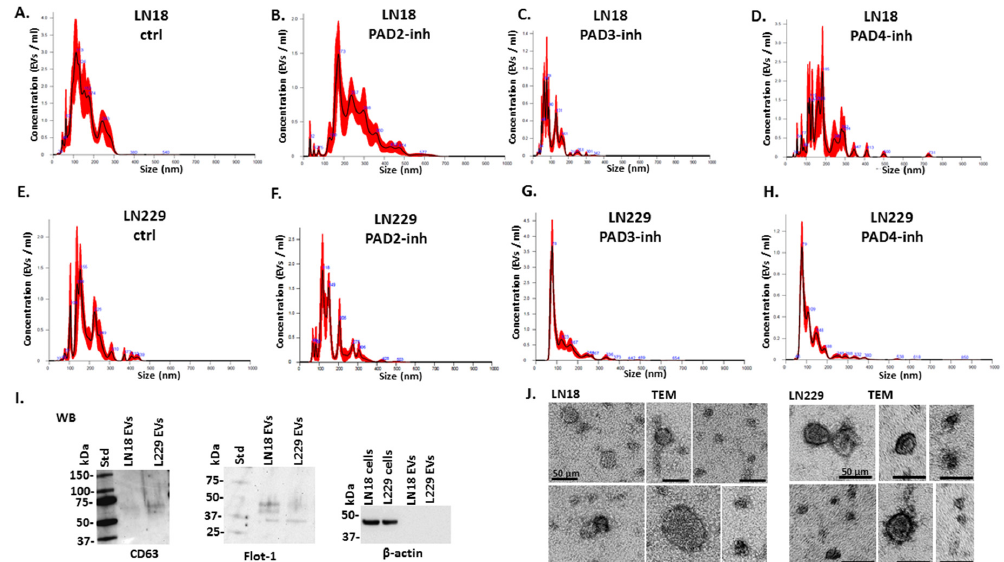
Figure 2. NTA size distribution profiles of EVs released from LN18 and LN229 cells following PAD isozyme-specific inhibitor treatment for 1 h and EV characterisation. Representative NTA profiles of LN18 cells following 1 h PAD inhibitor treatment ( A – D ): ( A ) Control DMSO treated cells; ( B ) PAD2 inhibitor treated cells; ( C ) PAD3 inhibitor treated cells; ( D ) PAD4 inhibitor treated cells. Representative NTA profiles of LN229 cells following 1 h PAD inhibitor treatment ( E – H ): ( E ) control DMSO treated cells; ( F ) PAD2 inhibitor treated cells; ( G ) PAD3 inhibitor treated cells; ( H ) PAD4 inhibitor treated cells. ( I ) Western blotting analysis (WB) showing that EVs isolated from LN18 and LN229 cells are positive for the EV specific markers CD63 and Flot-1; β -actin is absent from the EVs but present in the cells. ( J ) Transmission electron microscopy (TEM) images showing characteristic EV morphology for EVs isolated from both cell lines; the scale bar indicates 50 µm. In the NTA curves the black line represents the mean of the 5 repetitive readings per individual sample and the red line represents standard error (+/ − ) between those same 5 readings per sample. Each treatment group was measured in 3 biological replicates.